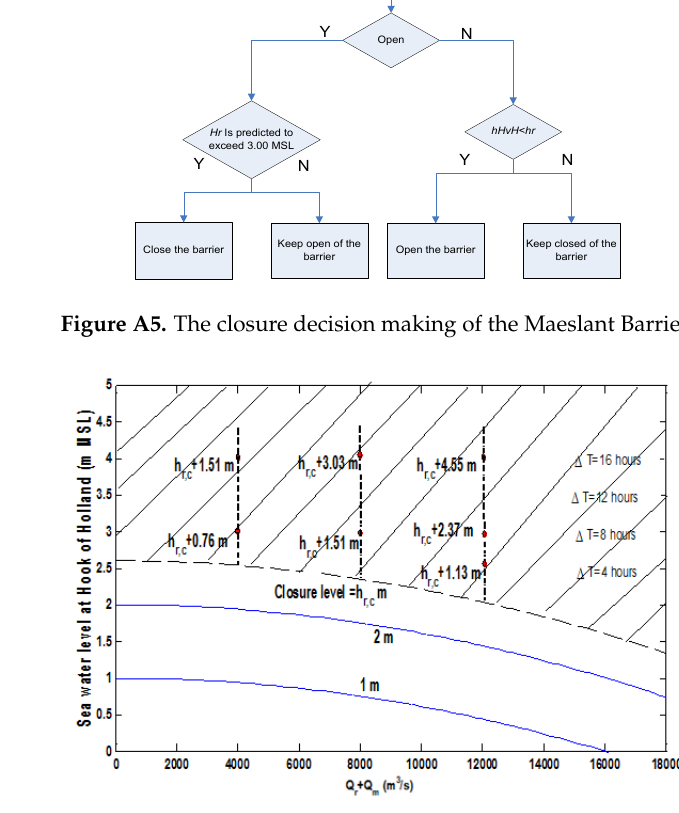
Figure A6. Equal Level Curves with the closable delta at Rotterdam.